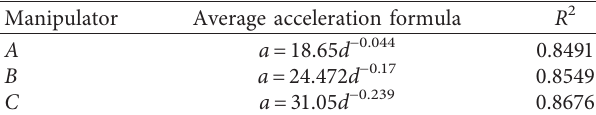
Figure 16: Average acceleration of grasping. Table 3: Average acceleration formula of